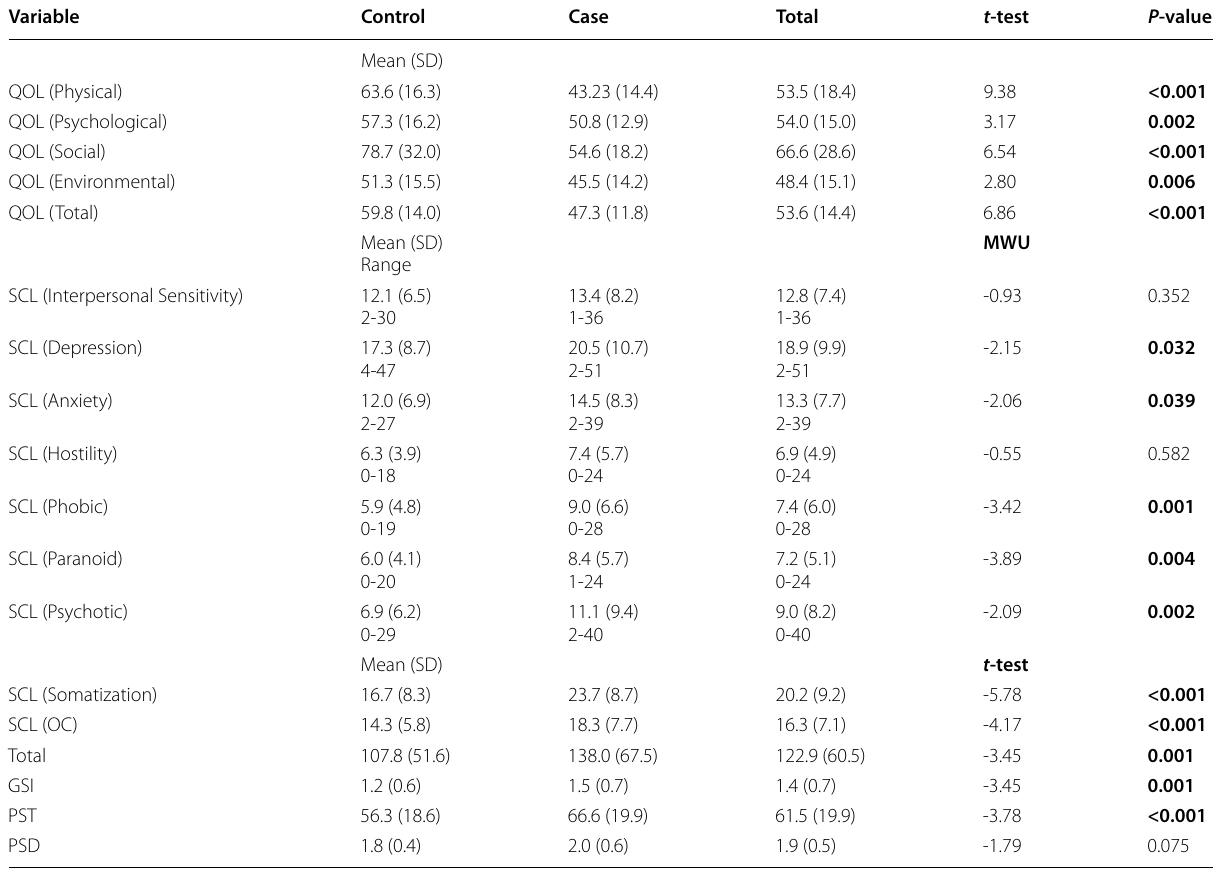
Significant values at P < 0.05 are presented as bold QoL Quality of life, SCL-90 Symptom Checklist-90 scale, OC Obsessive-compulsive, GSI Global Severity Index, PST Positive Symptoms Total, PSDI Positive Symptom Distress Index, QoL Quality of